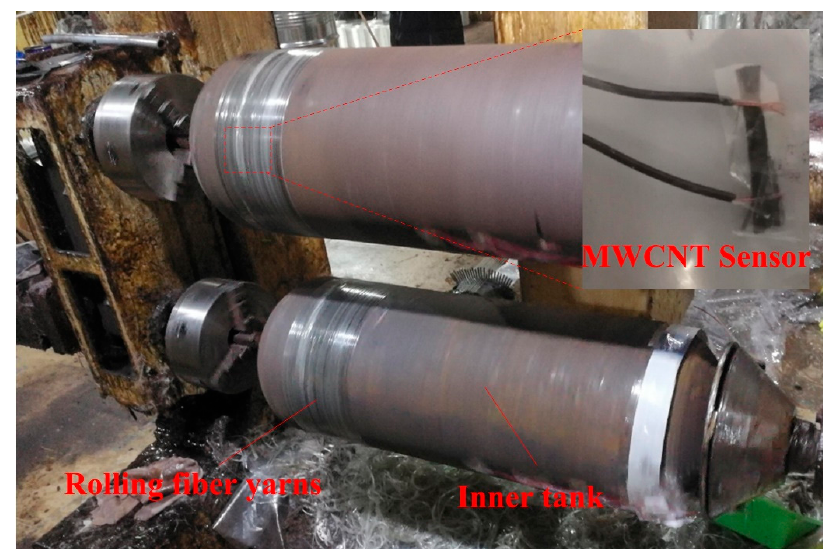
Figure 3. The MWCNT sensor is embedded in the middle thickness of the composite skin during the filament winding process.